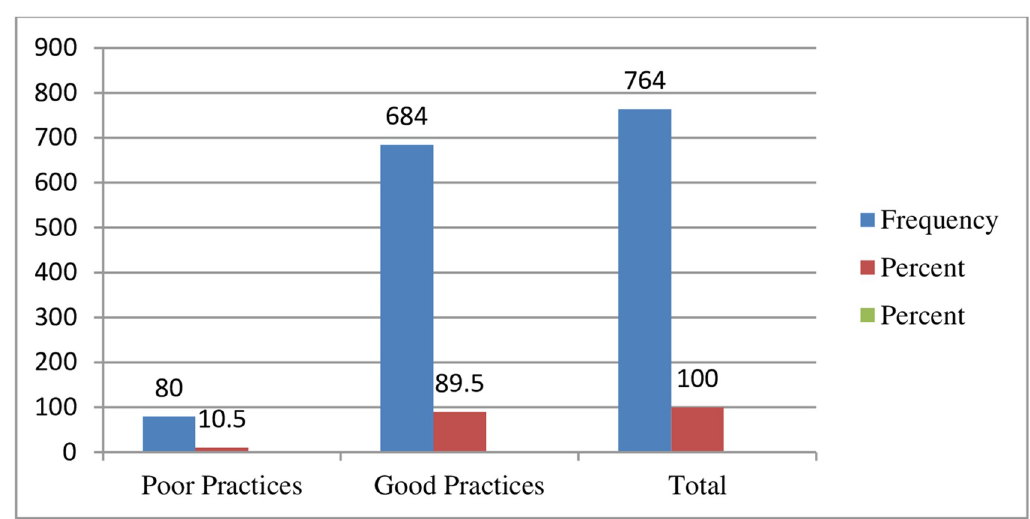
Fig 4. Practices-related questioner respondents on about knowledge, attitudes, and practices of face mask utilization and associated factors in COVID-19 pandemic among Wachemo university students, southern Ethiopia: February to March 2021 (n =